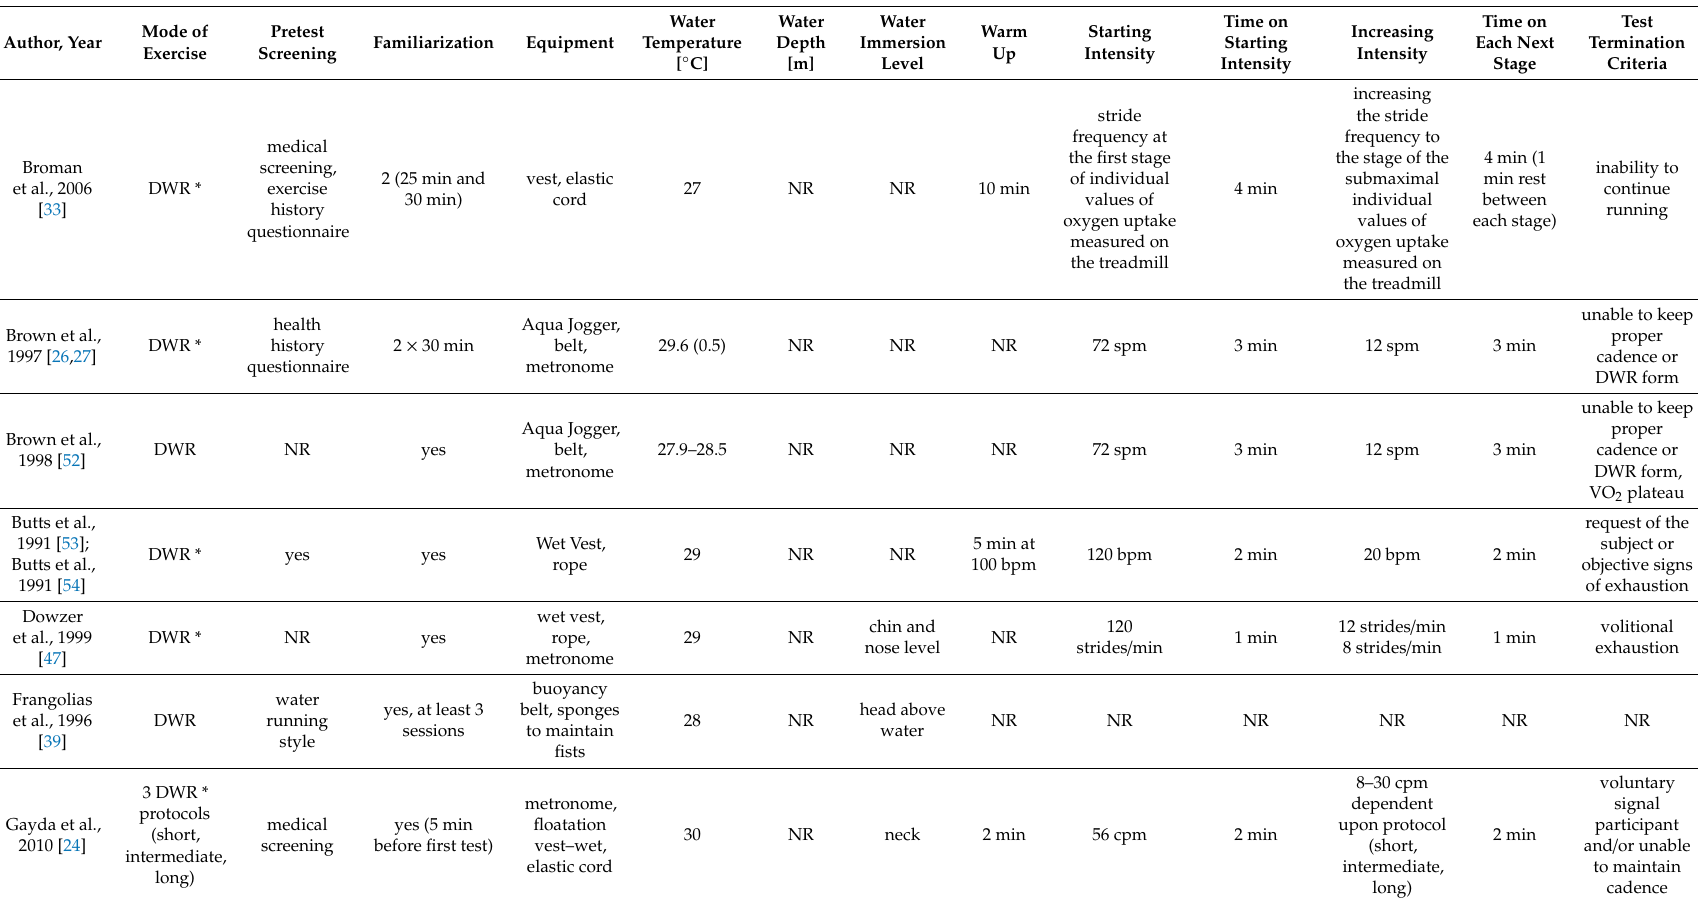
Table 2. Test protocols in deep